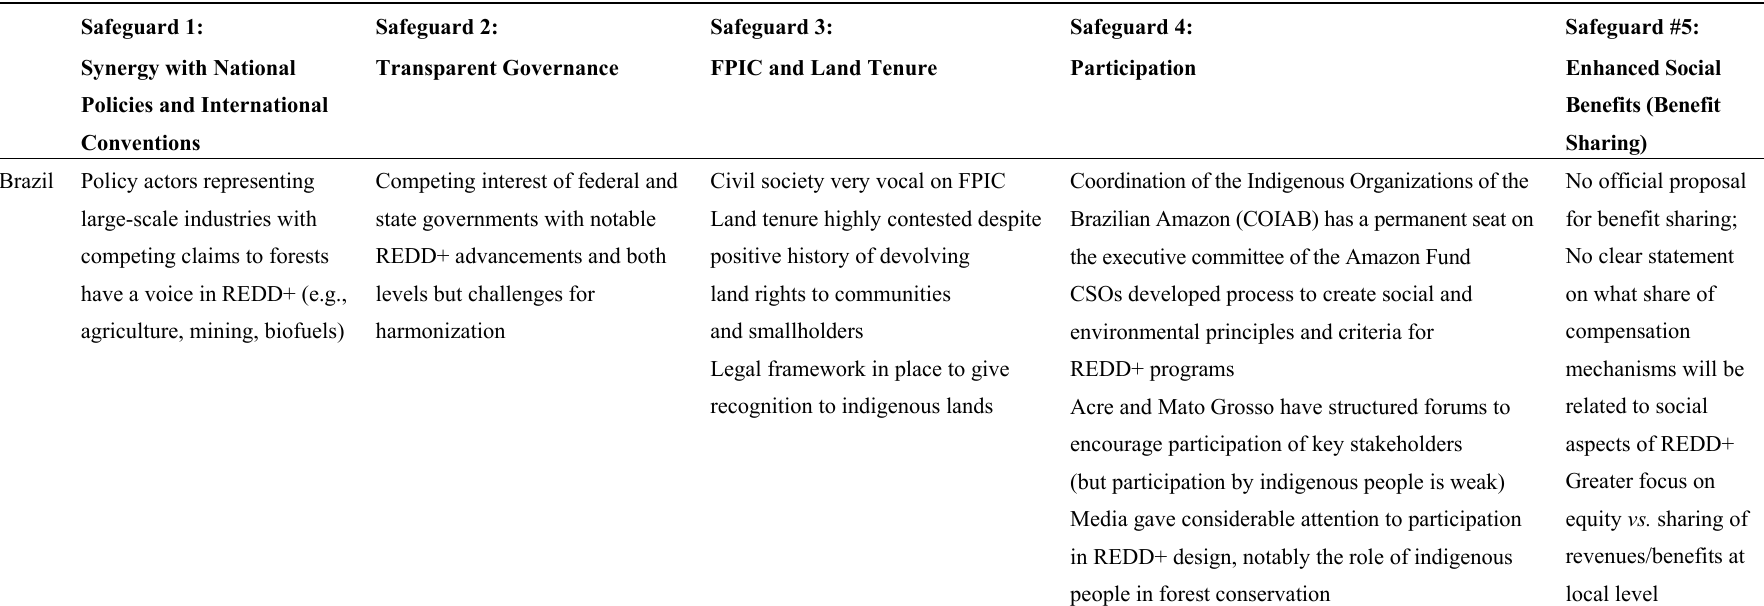
Table 1. Policy dialogues, processes and